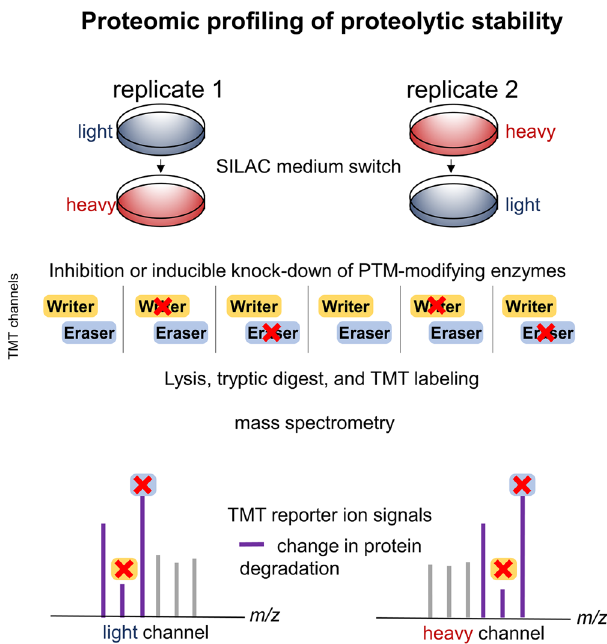
Fig. 6 | Proteomic pro fi ling of effects of PTM modulating enzymes on proteo- lytic stability. Schematic for using multiplexed proteome dynamics pro fi ling for detecting the effects of PTM writer and eraser enzymes on protein degradation. Cells are cultured in light SILAC medium or heavy SILAC medium. Following a switchtoheavySILACmedium(replicate1)orlightSILACmedium(replicate2),and subsequent inhibition of writer or eraser enzymes, samples are collected after a suitable time point, lysed, digested with trypsin, labeled with isobaric mass tag reagents (TMT), and pooled. Next, samples are processed by mass spectrometry. Tandem mass spectra generated from light and heavy SILAC signals will contain TMT reporter ions that can be used for relative quanti fi cation of changes in degradation rates between the different conditions (control, inhibition of writer enzyme, inhibition of reader enzyme) from the two biological